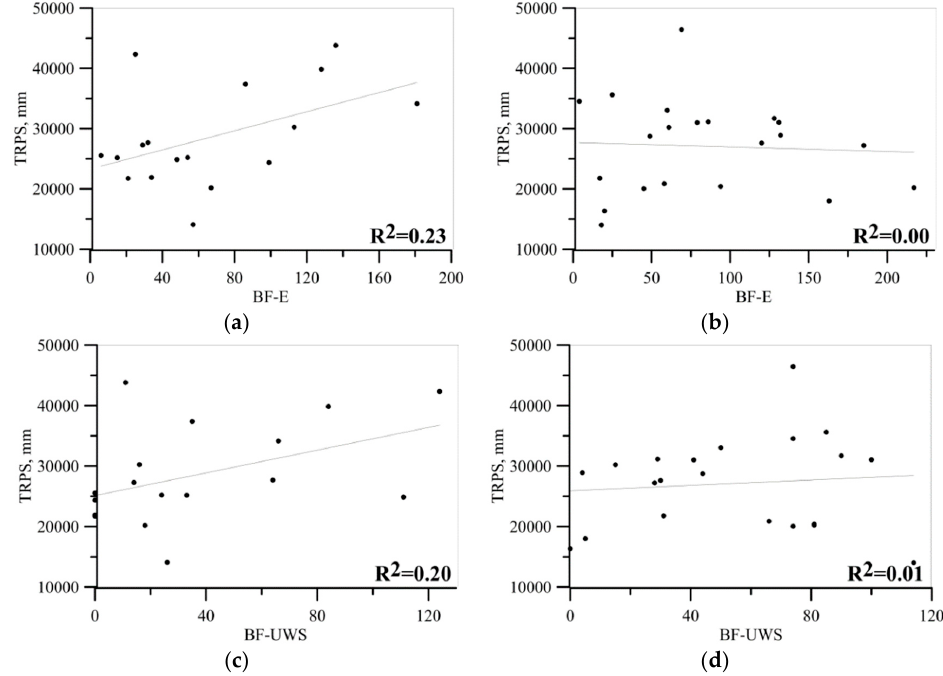
Figure 7. Scatterplots of the E-, UWS -BF, and TRPS for 1979–1995 ( a , c ), 1996–2016 ( b , d ). The solid line denotes the linear regression between two quantities found by the least-squares fit, and R 2 is shown at the bottom right.